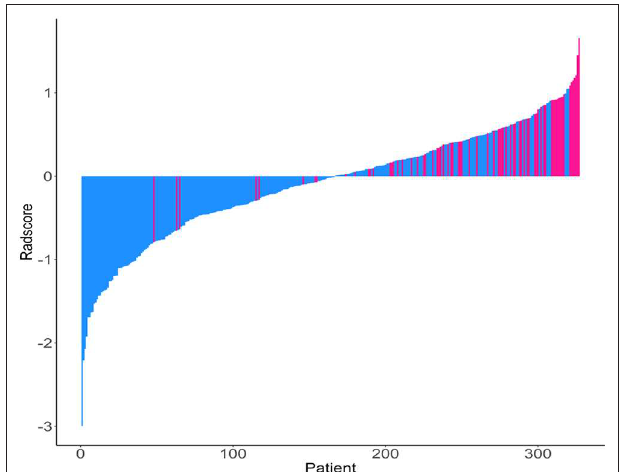
FIGURE 1 | Rad-score for each patient. Dodger blue bars show scores for patients who survived without disease progression or were censored, while deep pink bars show scores for those who experienced progression or died.